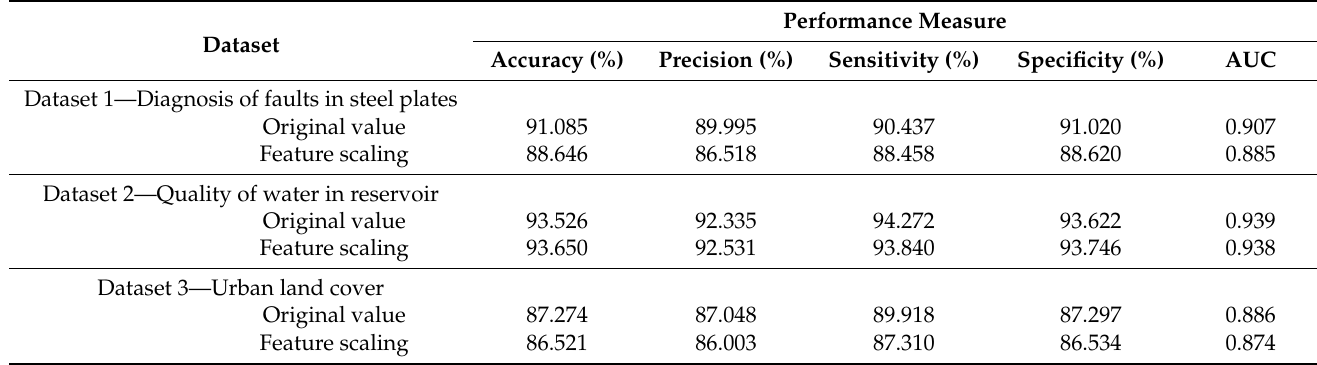
Table 12. Analytical results obtained using